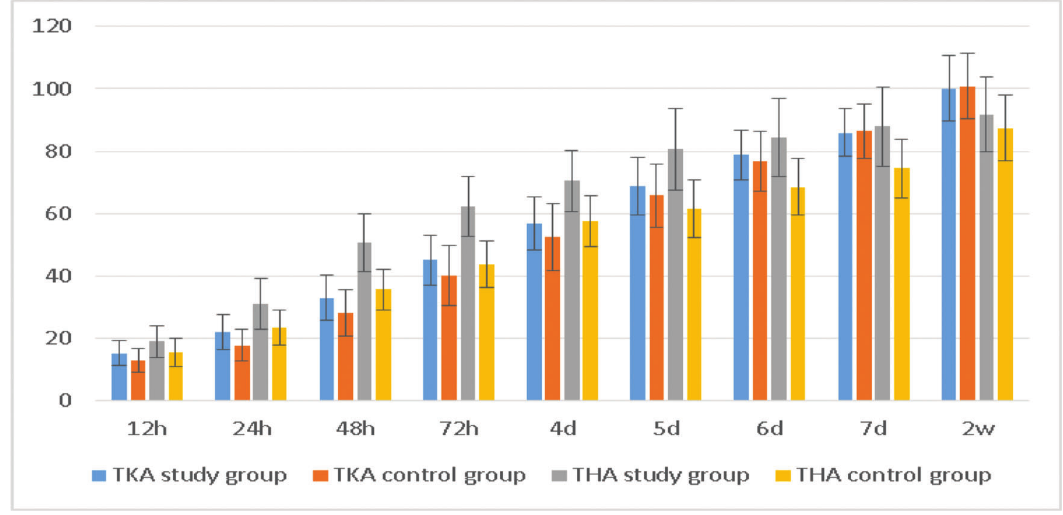
Figure 4 - Range of motion.